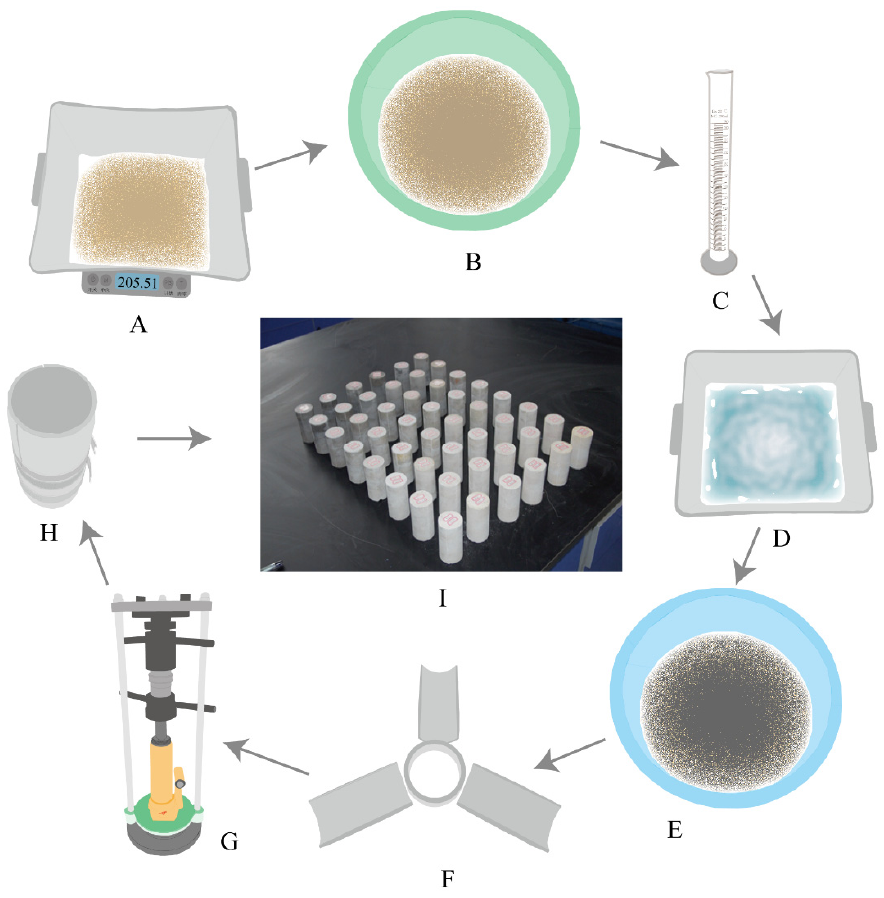
Figure 3. Specimen preparation process: ( A ) weighing; ( B ) dry material mixing; ( C ) water weighing; ( D ) gypsum retarder preparation; ( E ) wet material mixing; ( F ) mold preparation; ( G ) press molding with a jack; ( H ) grinding and standing; and ( I ) specimen maintenance.